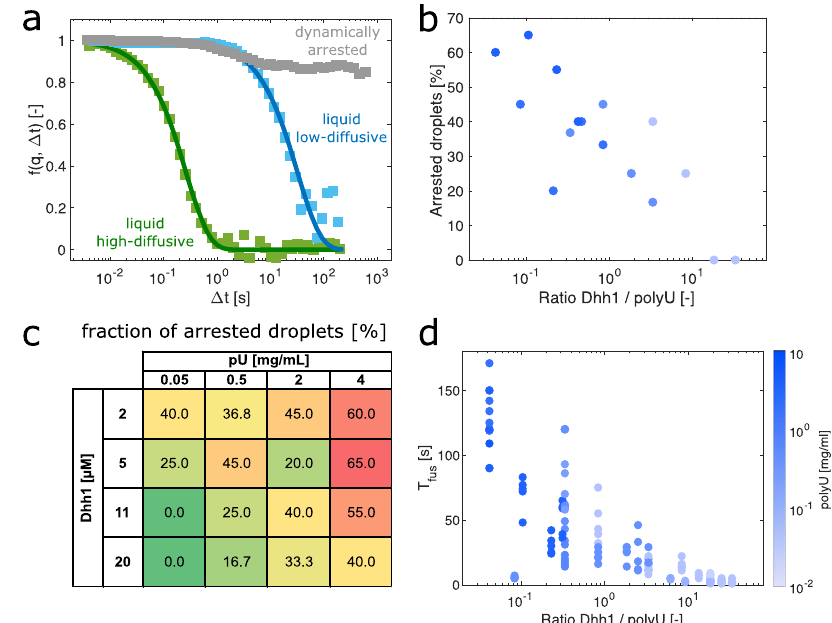
Fig. 4 Effect of the Dhh1/polyU ratio on the droplet material properties. a Representative ISFs f ( q , Δ t ) of liquid-like, high-diffusive (green curve), and low-diffusive (blue curve) droplets, and dynamically arrested condensates (gray squares) observed in samples containing various Dhh1/polyU ratios. b – d Increase of the fraction of dynamically arrested droplets at low Dhh1/polyU ratios, as measured by DDM ( b , c ), which is consistent with the increase in the fusion time T fus of the condensates (in d ). In panel c , numbers indicate the fraction of arrested droplets in %. A high fraction of dynamically arrested droplets is highlighted in red, a low fraction is highlighted in green. The color bar in panel d describes the absolute polyU concentration used in panels b , d . In b , c , the fraction of arrested droplets was calculated by analyzing at least 15 different condensates in three independent samples. Source data for panels b – d are provided in the Source Data fi